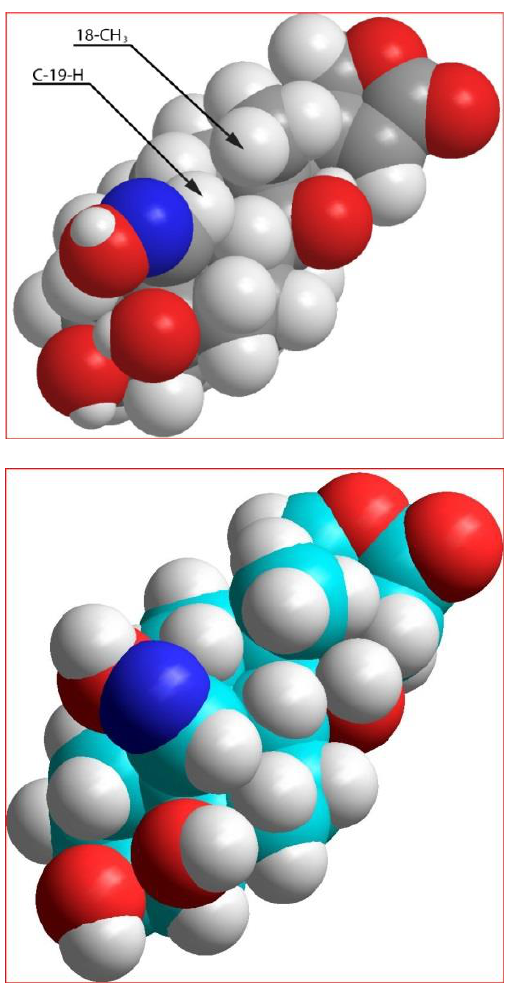
Fig. 3. Limited rotation around the single bond C10-C19